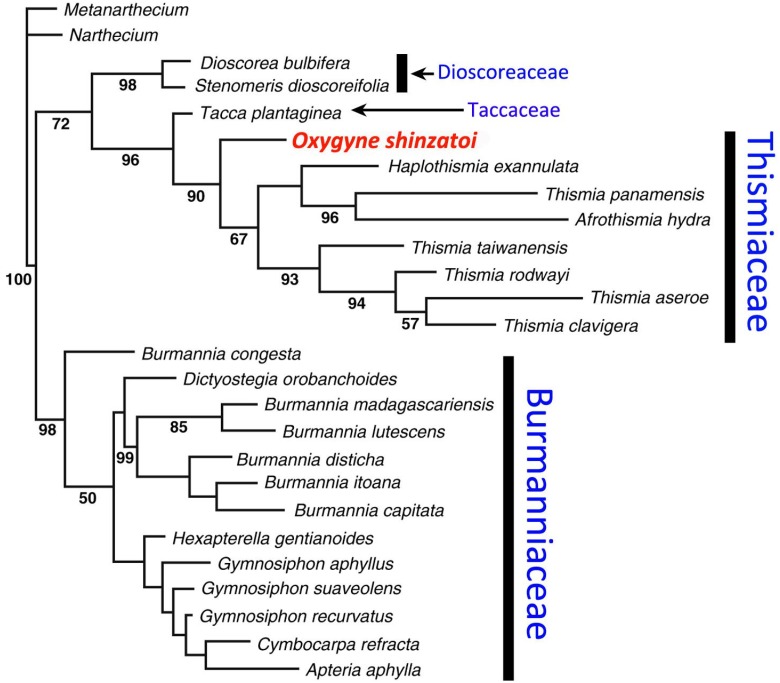
Phylogenetic placement of Oxygyne based on phylogeny in Yokoyama et al. (2008).